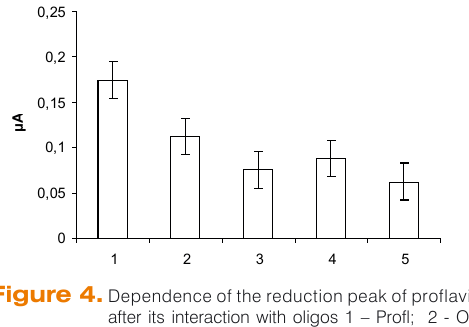
Figure 4. Dependence of the reduction peak of proflavine(profl) after its interaction with oligos 1 – Profl; 2 - Oligo(2+3,